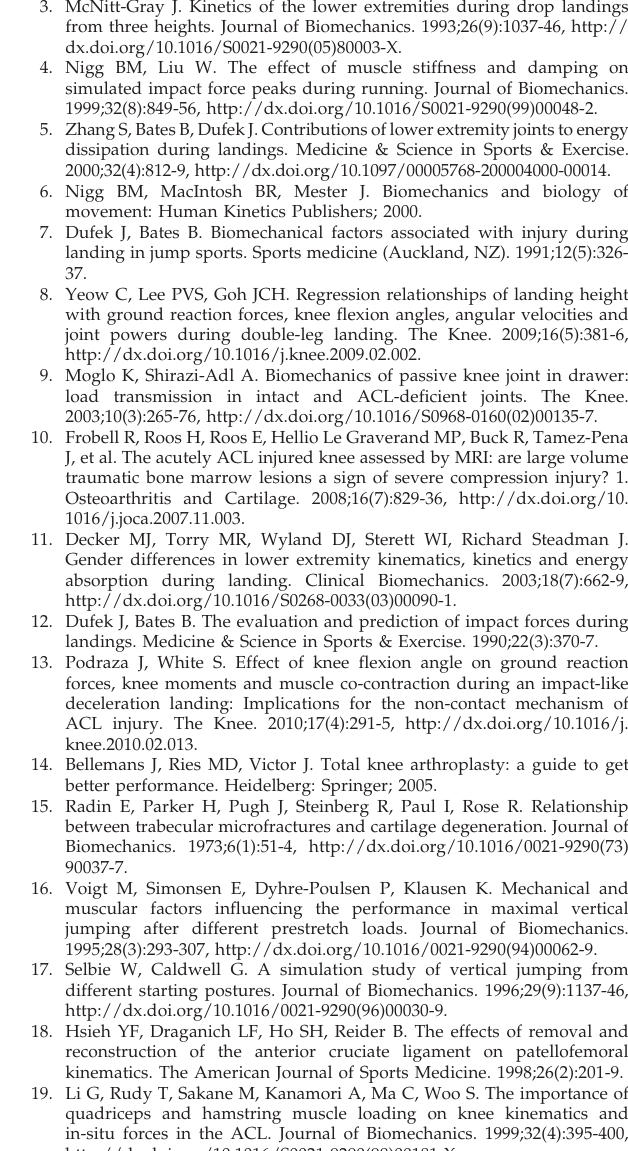
Figure 5 - Maximum penetration of the knee joints: a) the distance before landing and b) the distance